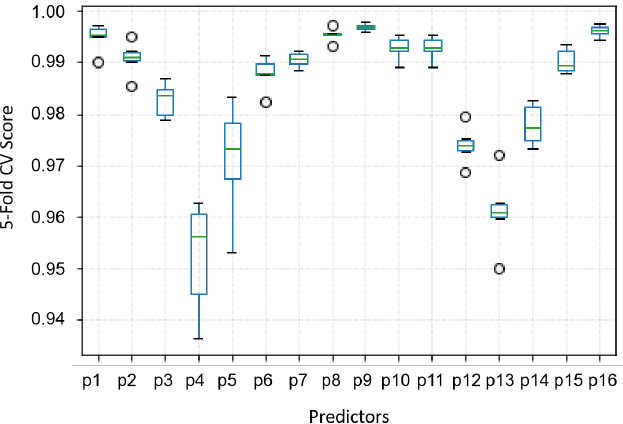
Figure 3. Five-fold cross validation score of d 1 to d 16 on training